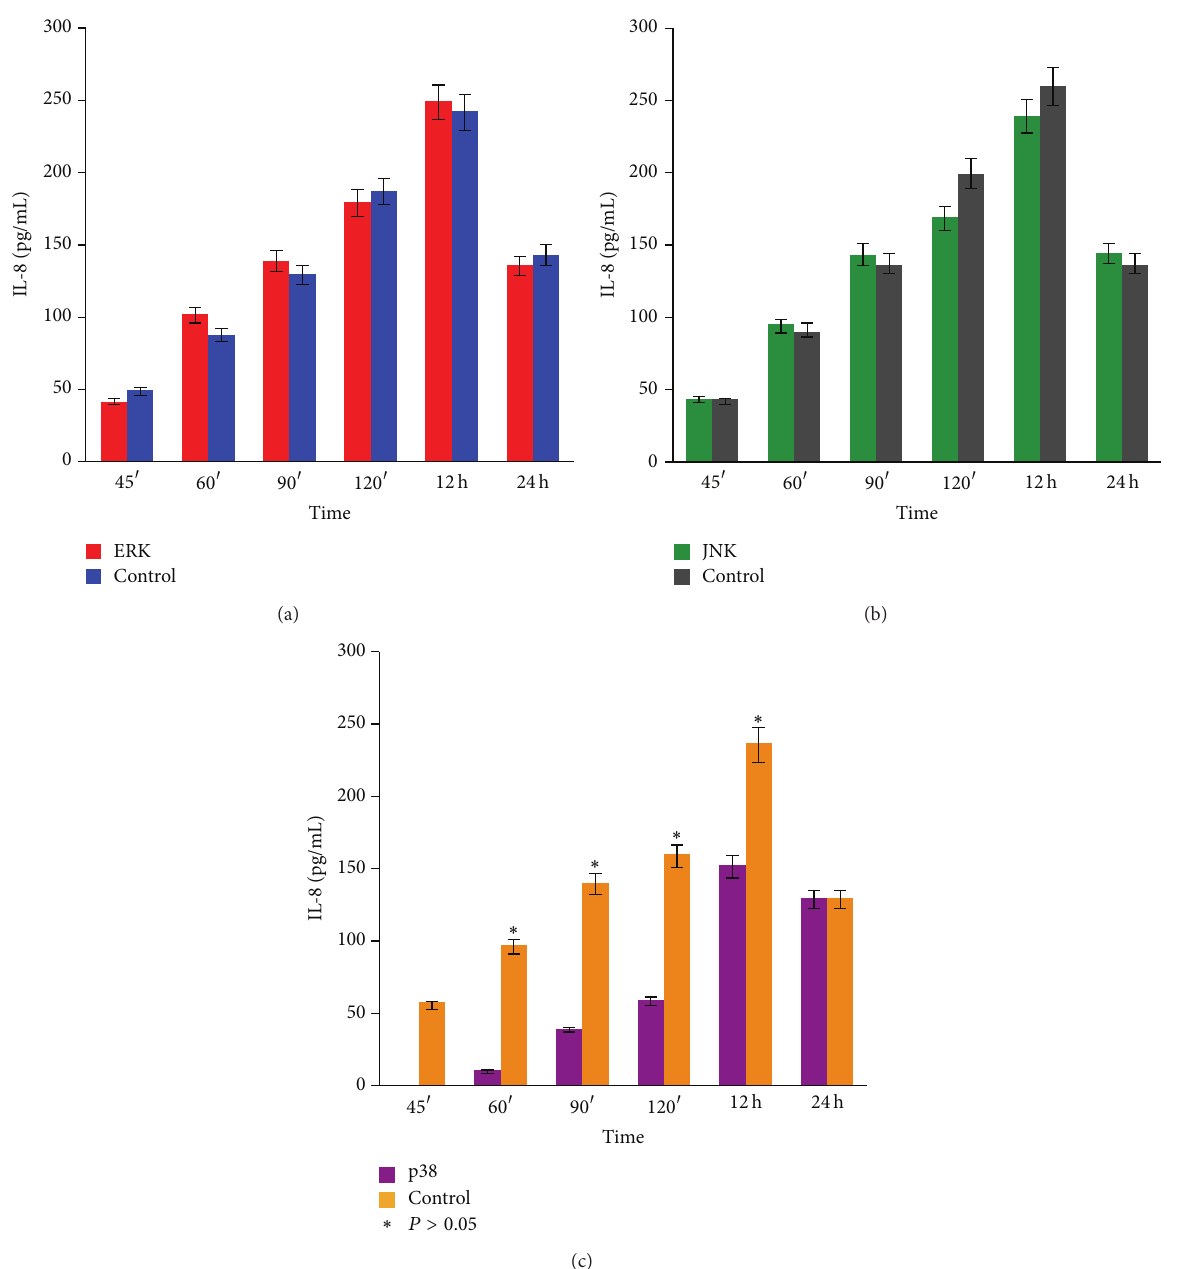
Figure 9: Kinetic inhibition of MAPKs. ELISA quantitation of IL-8 concentrations in cells pretreated with ERK1/2 PD980559, JNK SP600125, and SB203580 inhibitors. Control is HEp-2 cells infected with live HPIV-1. (a) ERK1/2 inhibitor assay is displayed in red cells treated with the inhibitor. (b) JNK inhibitor assay, green, occurs in cells treated with the inhibitor. (c) p38 inhibitor assay, purple, occurs in cells treated with inhibitor. Data are the means ± SD for triplicate measurements from the three separate